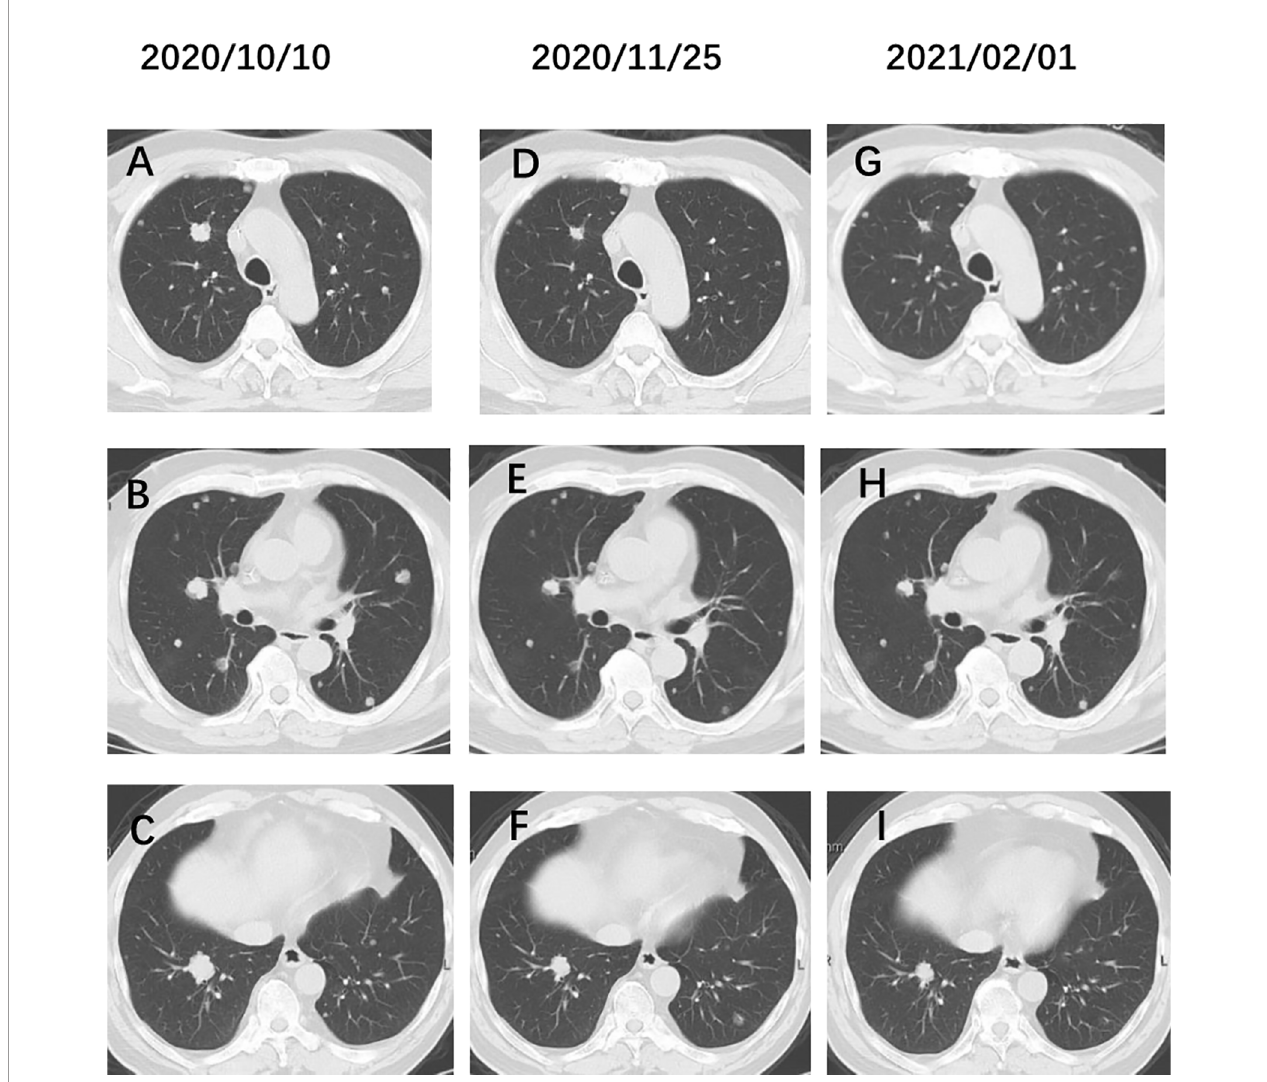
FIGURE 3 | (A – C) Chest CT before administration of Irinotecan. (D – F) Chest CT after 3 cycles Irinotecan and bevacizumab therapy. (G – I) After 6 cycles Irinotecan and bevacizumab therapy. The pulmonary metastatic lesions were reduced by